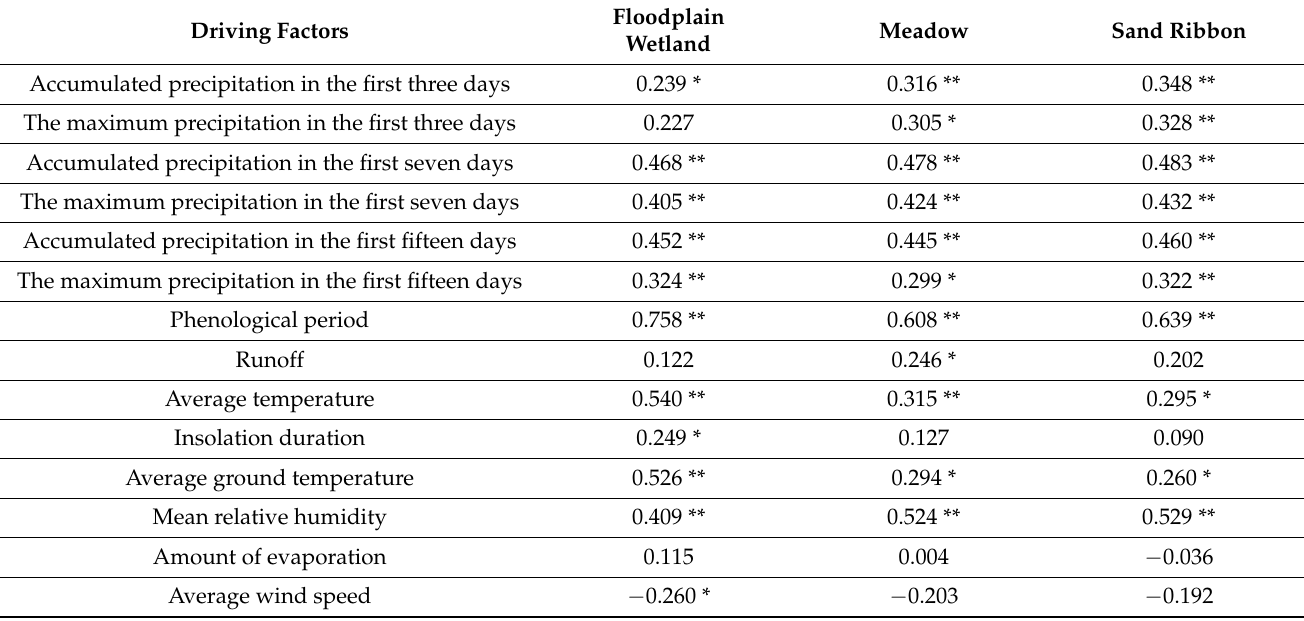
Table 3. Correlation analysis between driving factors and the NDVI of each ecosystem.